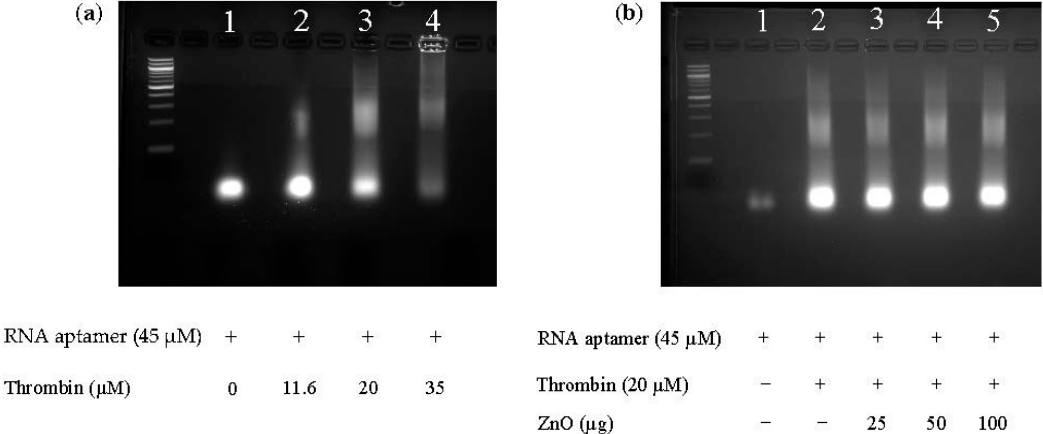
Figure 5. Electrophoretic mobility shift assay (EMSA) of ( a ) RNA aptamer with varying concentrations of thrombin and ( b ) RNA aptamer with or without thrombin and with varying concentrations of ZnO.